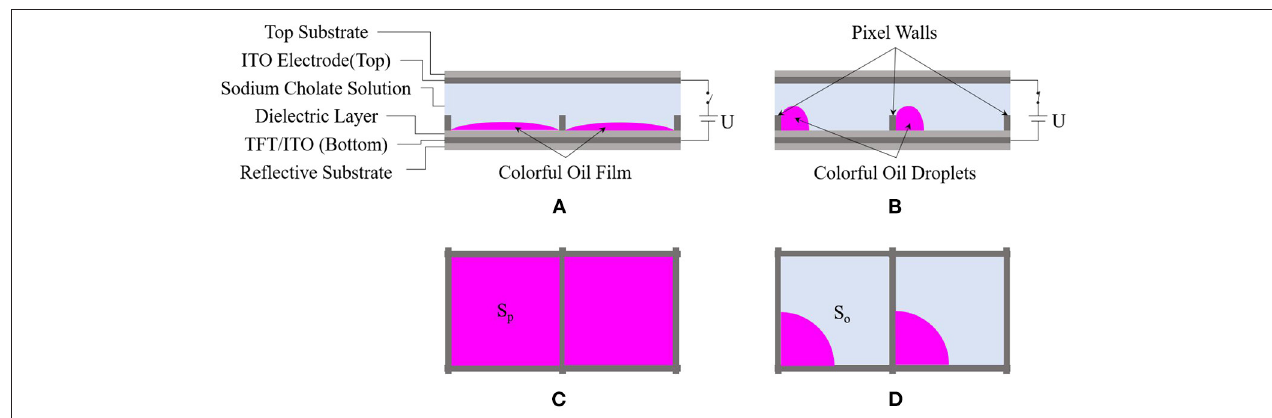
FIGURE 2 | Schematic diagram of EWDs. When no voltage was applied, the colored oil was evenly spread out in the pixel grid, (A) is a side sectional view, (C) is a top view. When a voltage was applied, the spread oil film was squeezed to a corner of the pixel grid, (B) is the side cross-sectional view, (D) is the top view.